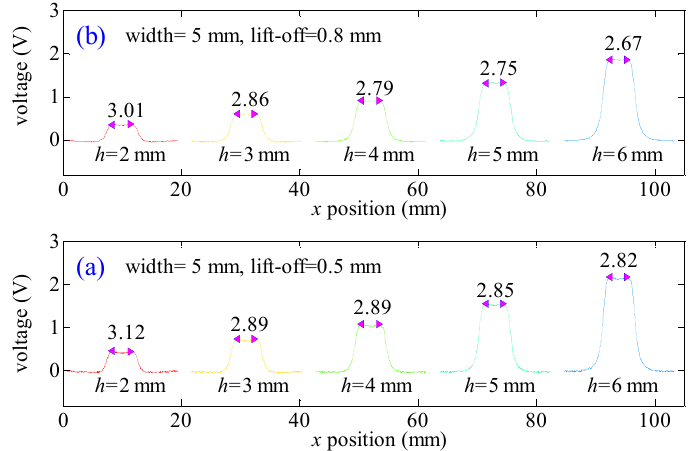
Figure 14. MFL signals for defects of different depth values: ( a ) lift-off value is 0.5 mm and ( b ) lift-off value is 0.8 mm.